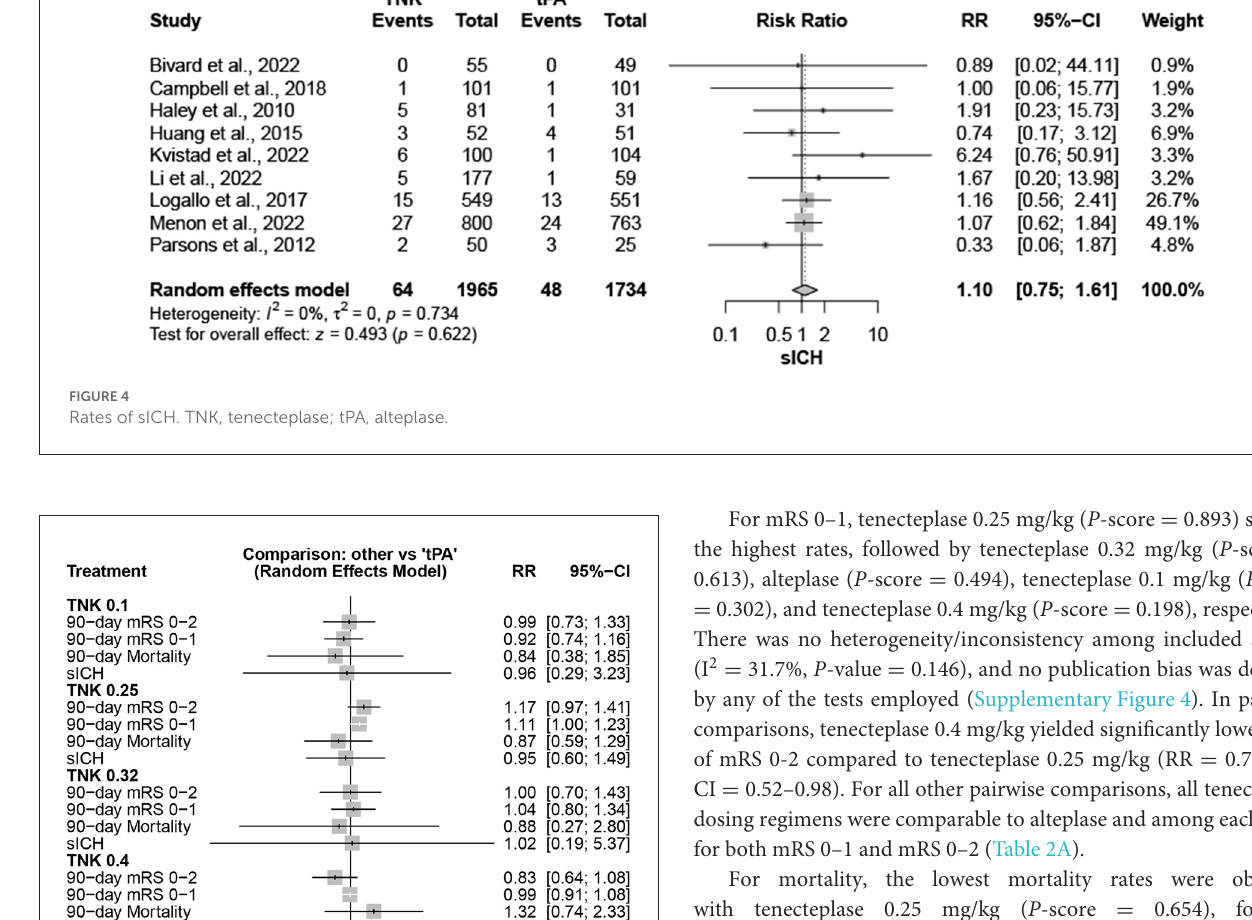
FIGURE5 Different doses of tenecteplase (TNK) vs. alteplase (tPA).